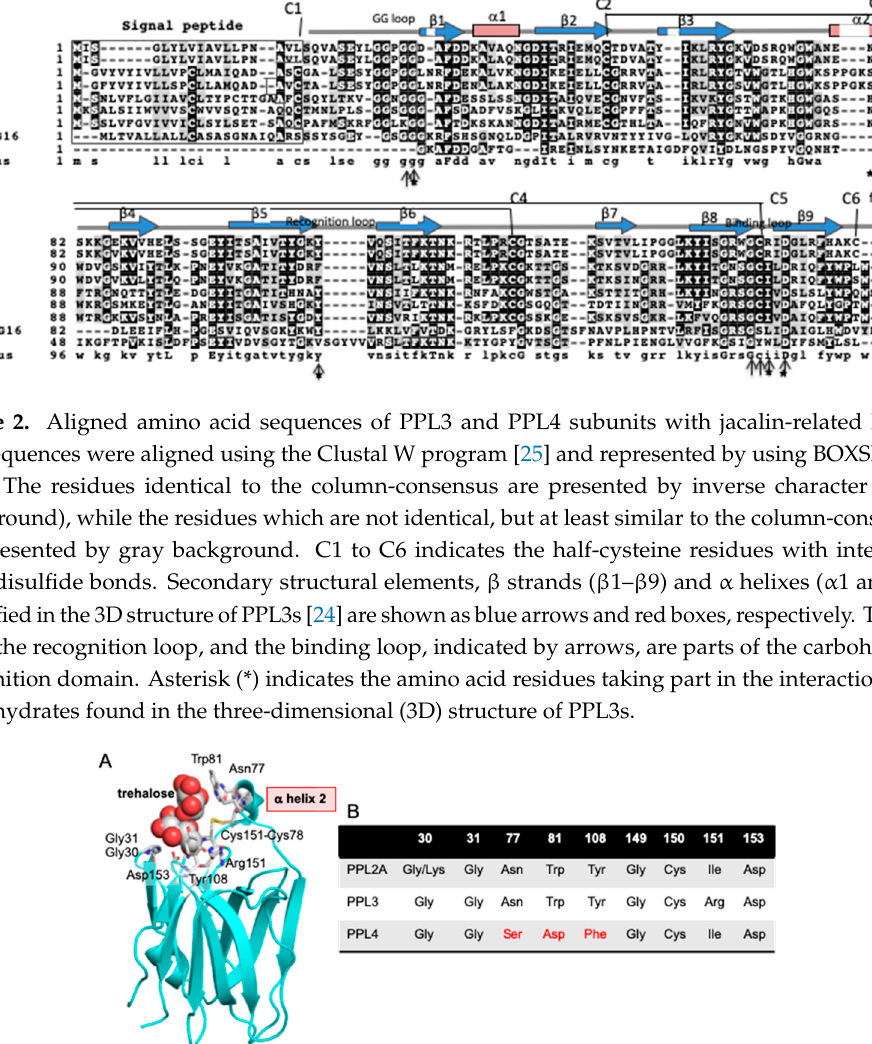
Figure 3. Schematic structure of PPL3 subunit conjugated with trehalose ( A ) and a comparison of the amino acid residues of carbohydrate recognition domains (CRDs) among PPL2A, PPL3s, and PPL4 ( B ). The 3D structure of PPL3s with trehalose (PDB ID 5yrf) was visualized by using Pymol 2.3 [26]. Trehalose ligands and amino acid residues involved in carbohydrate binding are indicated by spheres and sticks model, respectively.